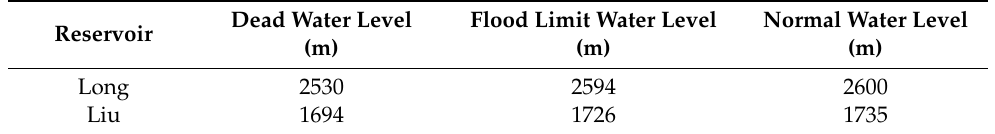
Figure 3. Relative locations of hydrological stations and hydropower reservoirs at the UYR. Table 1. Characteristic water levels of Long and Liu reservoirs.